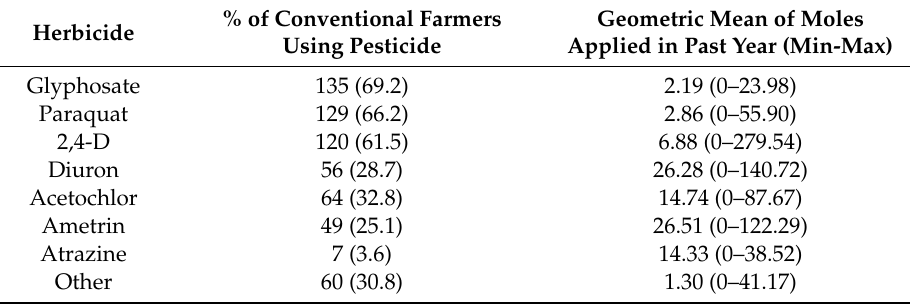
Table 5. Herbicide use patterns among conventional farmers ( n =